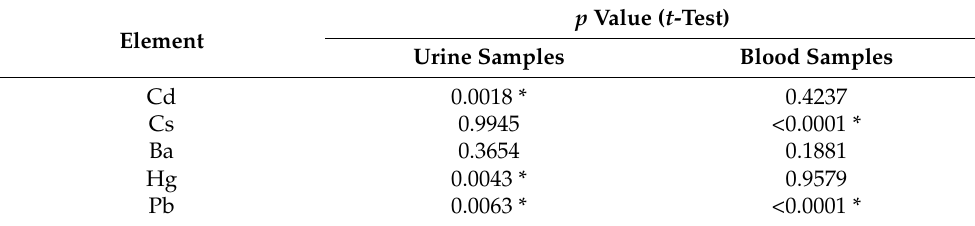
Table 3. Cont. p Value ( t -Test) Element Urine Samples Blood Samples Cd 0.0018 * 0.4237 Cs 0.9945 <0.0001 * Ba 0.3654 0.1881 Hg 0.0043